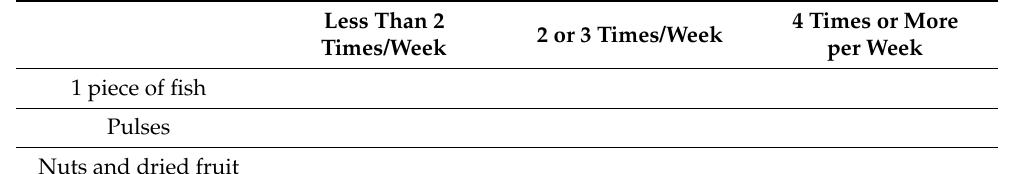
Table A3. Eating habits